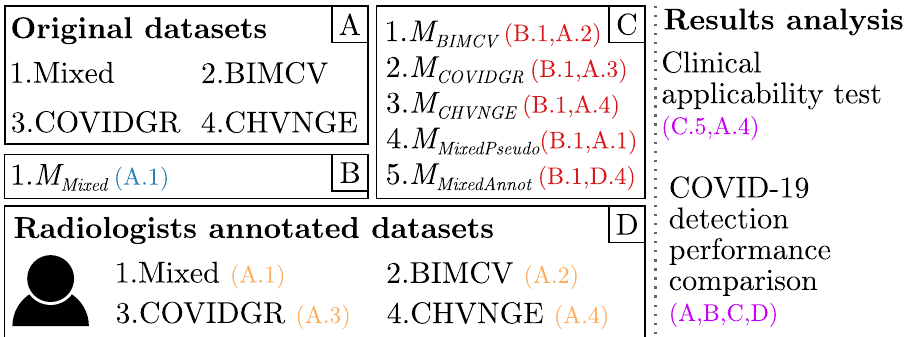
Figure 2. Summary of the study. Each (letter.number) indicates the data/model used for performing the task encoded by the respective